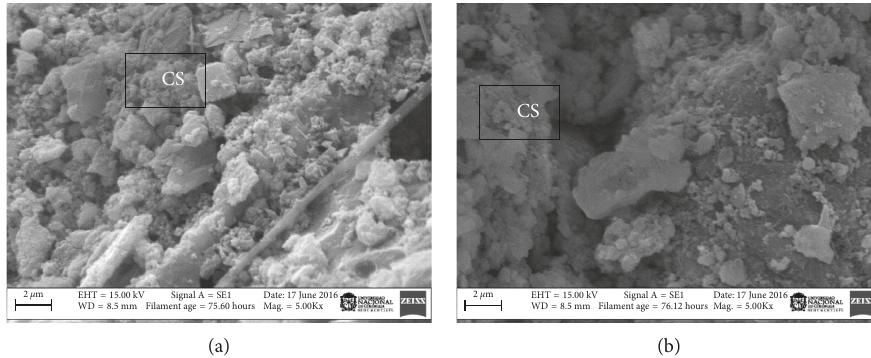
Figure 10: Aggregate zone of (a) ALC5S-0 and (b) AlC5S-10.